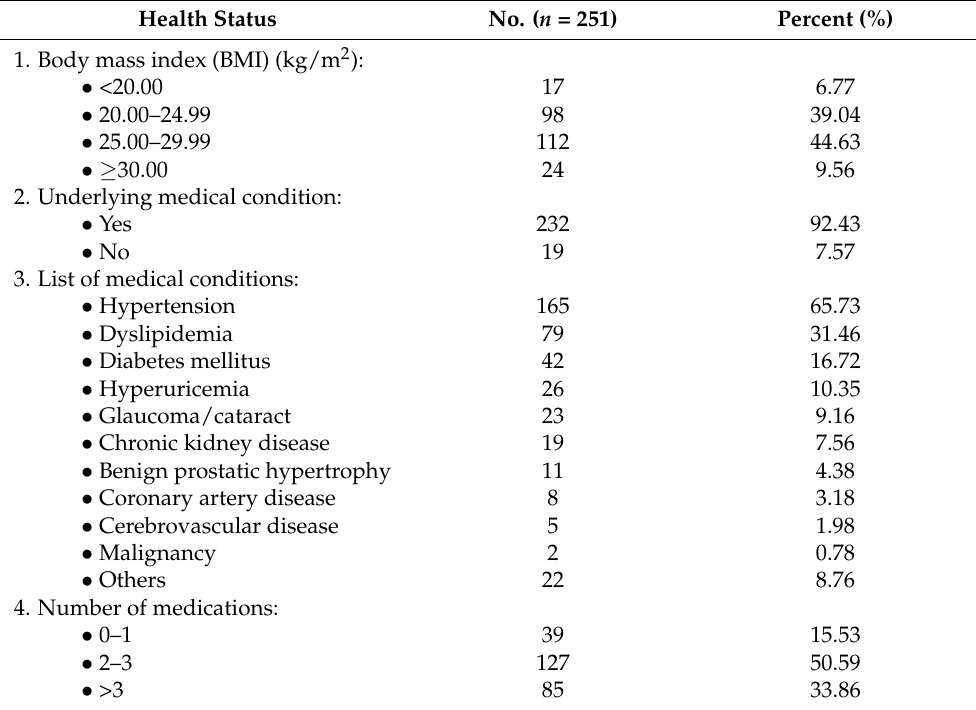
Table 2. Health status baseline of participants.